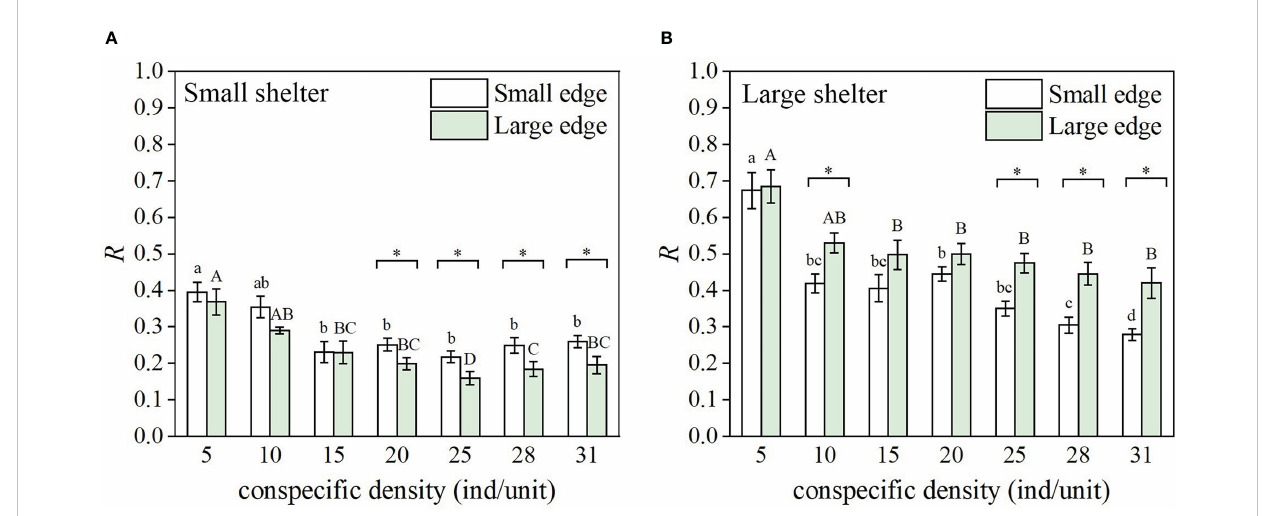
FIGURE 3 Aggregation rate ( R ) (n = 6, mean ± SE) of fat greenling ( Hexagrammos otakii) under the seven density treatments in the reef unit with (A) small shelter and (B) large shelter. Different lower-case letters represent signi fi cant differences among densities for the small edge (Tukey ’ s test, p < 0.05); different capital letters represent signi fi cant differences among densities for the large edge (Tukey ’ s test, p < 0.05); * indicates a signi fi cant difference between the small edge and large edge for same density and shelter (Tukey ’ s test, p <